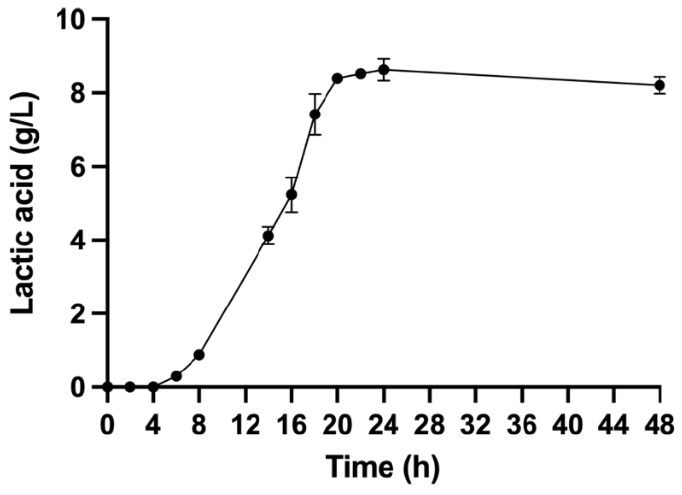
Figure 4. Lactic acid production curve determined during oatmeal fermentation. Each result reported is a mean value of a triplicate analysis and error bars indicate the corresponding standard deviations.